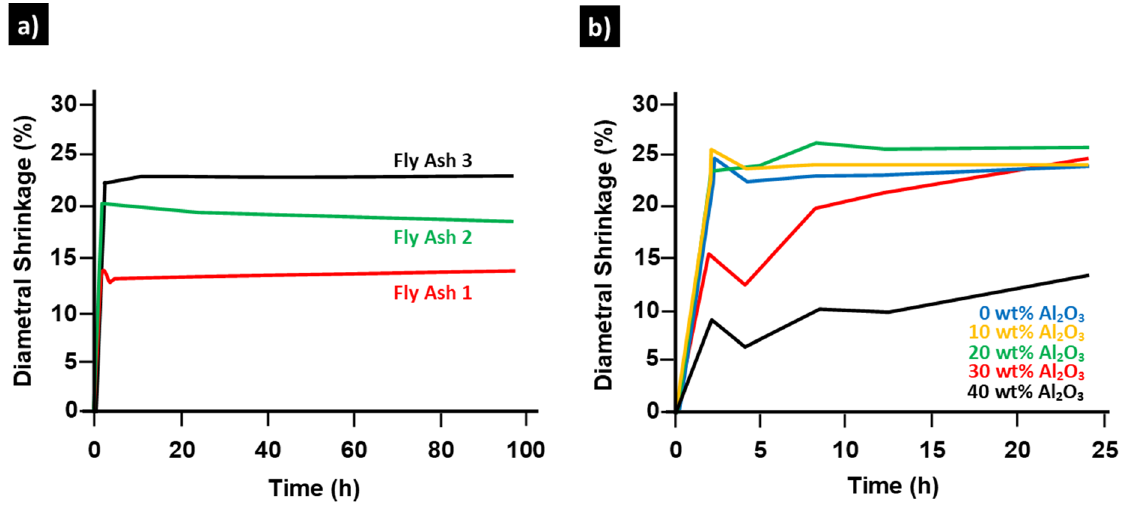
Figure 3. ( a ) Diametral firing shrinkages of pure fly ashes (1, 2, and 3) after sintering at 1500 ◦ C for ≤ 96 h, ( b ) Diametral firing shrinkages of fly ash 3 with alumina additions after sintering at 1500 ◦ C for ≤ 24 h (Adapted from